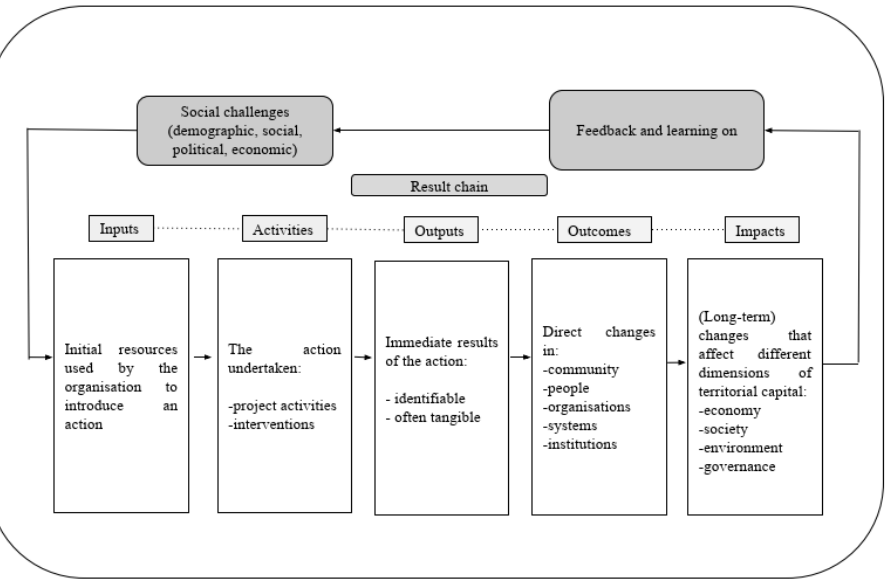
Figure 1. Result-chain based on the Theory of Change (ToC) key elements. Source: own elaboration based on Secco et al. (2019b).